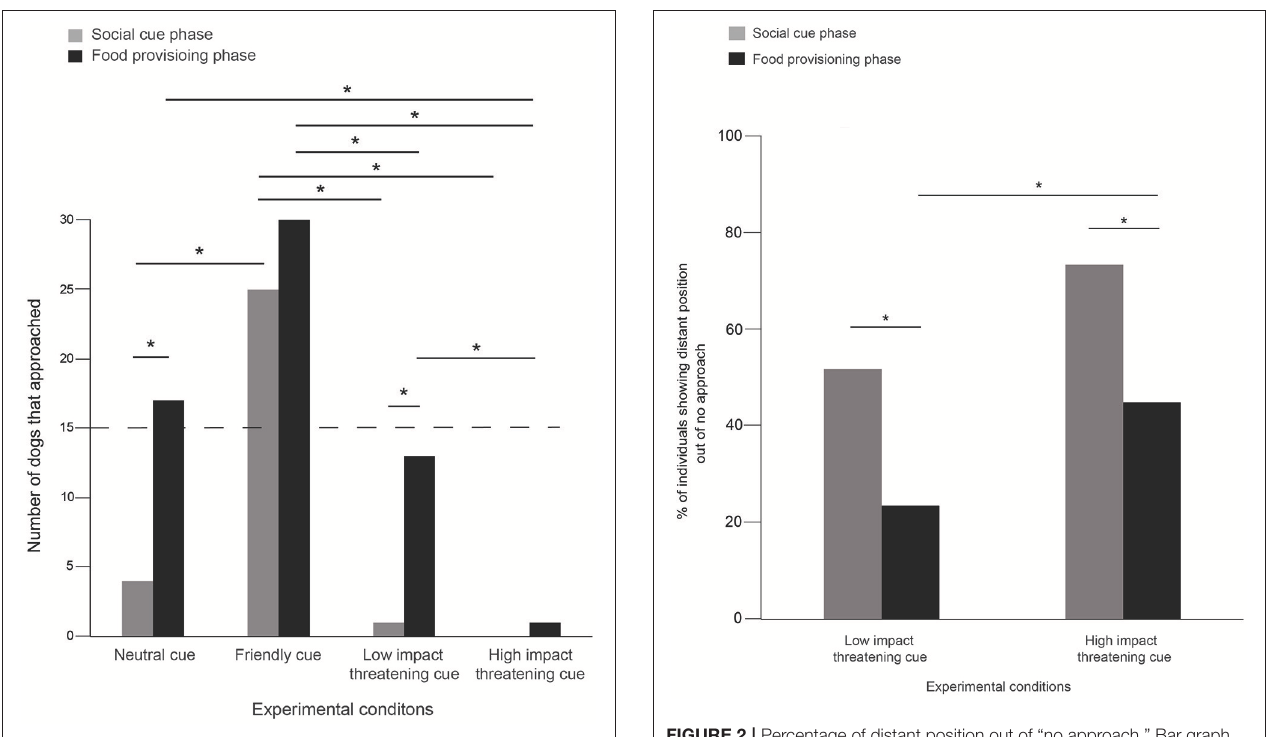
FIGURE 1 | Number of approaches. Bar graph showing the number of approaches in the SCP and FPP of the four experimental conditions—NC, FC, LIT, and HIT. Number of dogs that approached varied between the phases across the conditions (Contingency χ 2 : χ 2 = 10.439, df = 3, p = 0.015). Asterisks indicated significant differences. The dotted line indicates the chance level (50%).